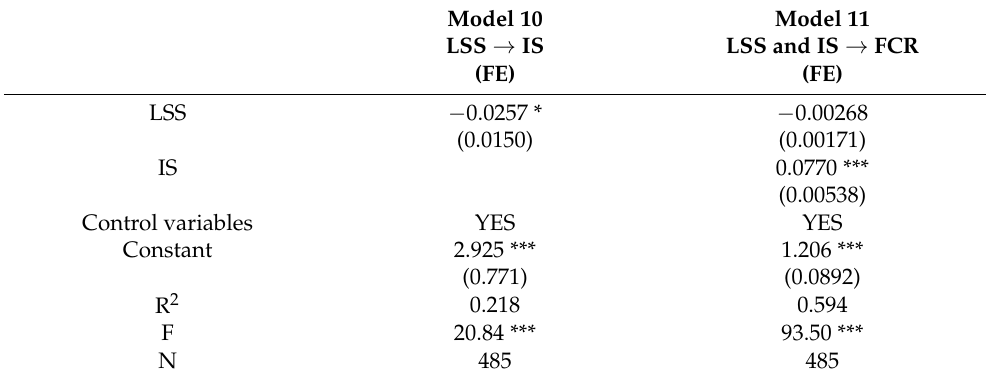
Table 6. Mediation effect